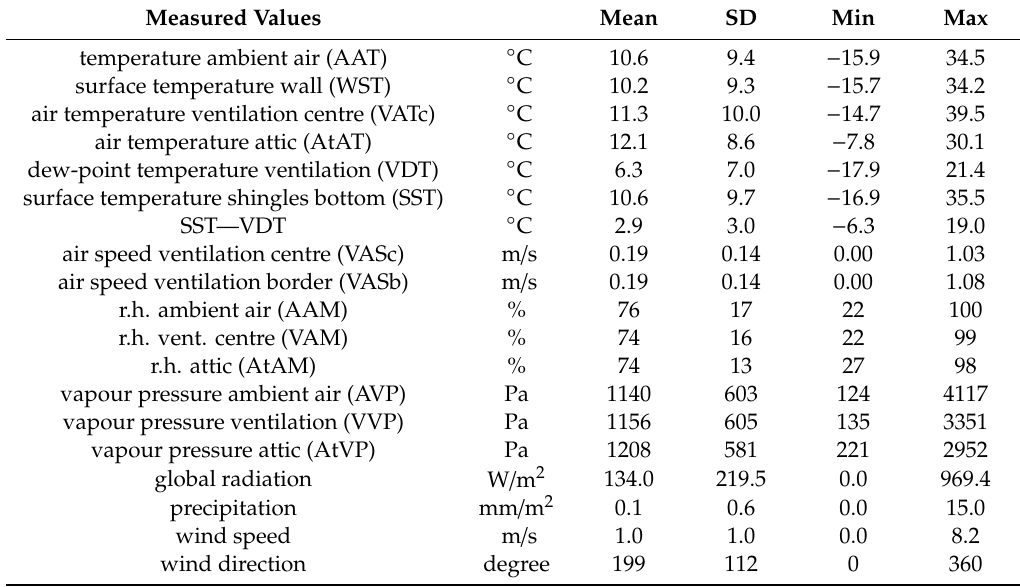
Figure 3. Various temperatures over the total measuring time. Table 1. Descriptive statistics of measured values and climate